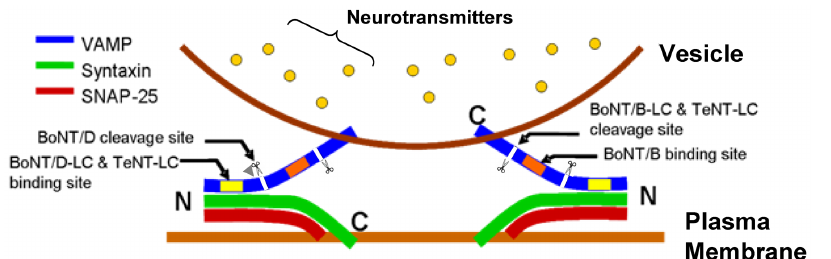
Figure 9. The trans -SNARE complexes at phasic and tonic synapses are partially zippered under resting state. The N-terminal end of the SNARE complex is zippered whereas the C-terminal end is exposed. The binding and cleavage sites of BoNT/B are exposed but the shared binding site for TeNT and BoNT/D, and possibly the cleavage site for BoNT/D, are occluded. Scissors and white lines indicate neurotoxin cleavage site. Gray arrow head indicates the location of the zero-layer across all three SNARE